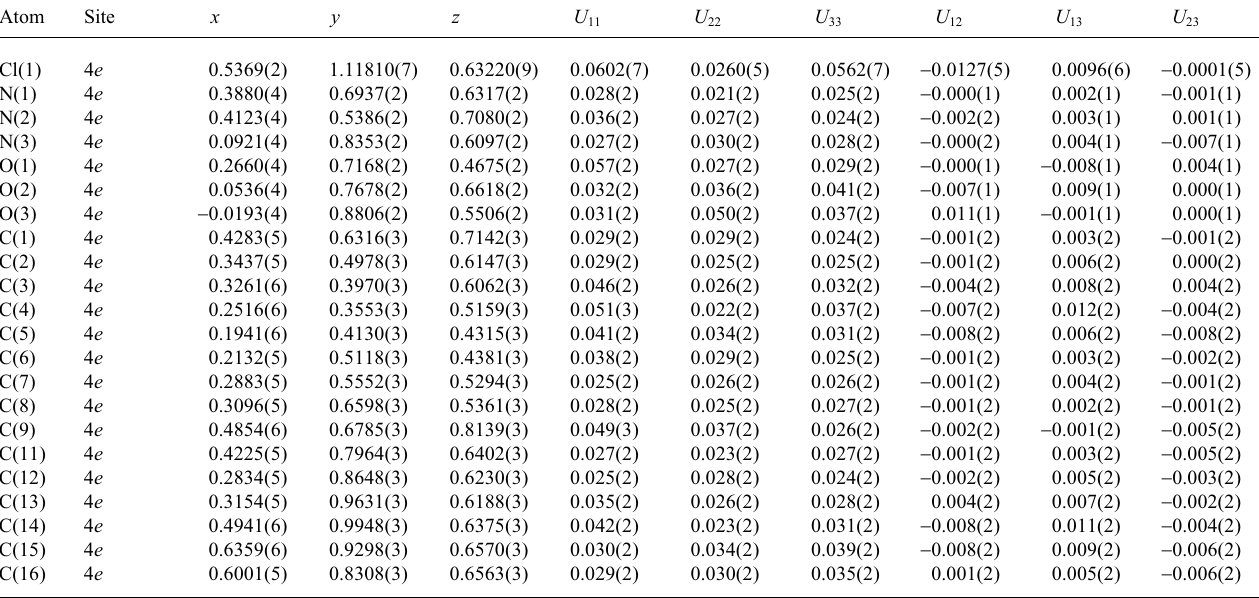
Table 3. Atomic coordinates and displacement parameters (in Å 2 )